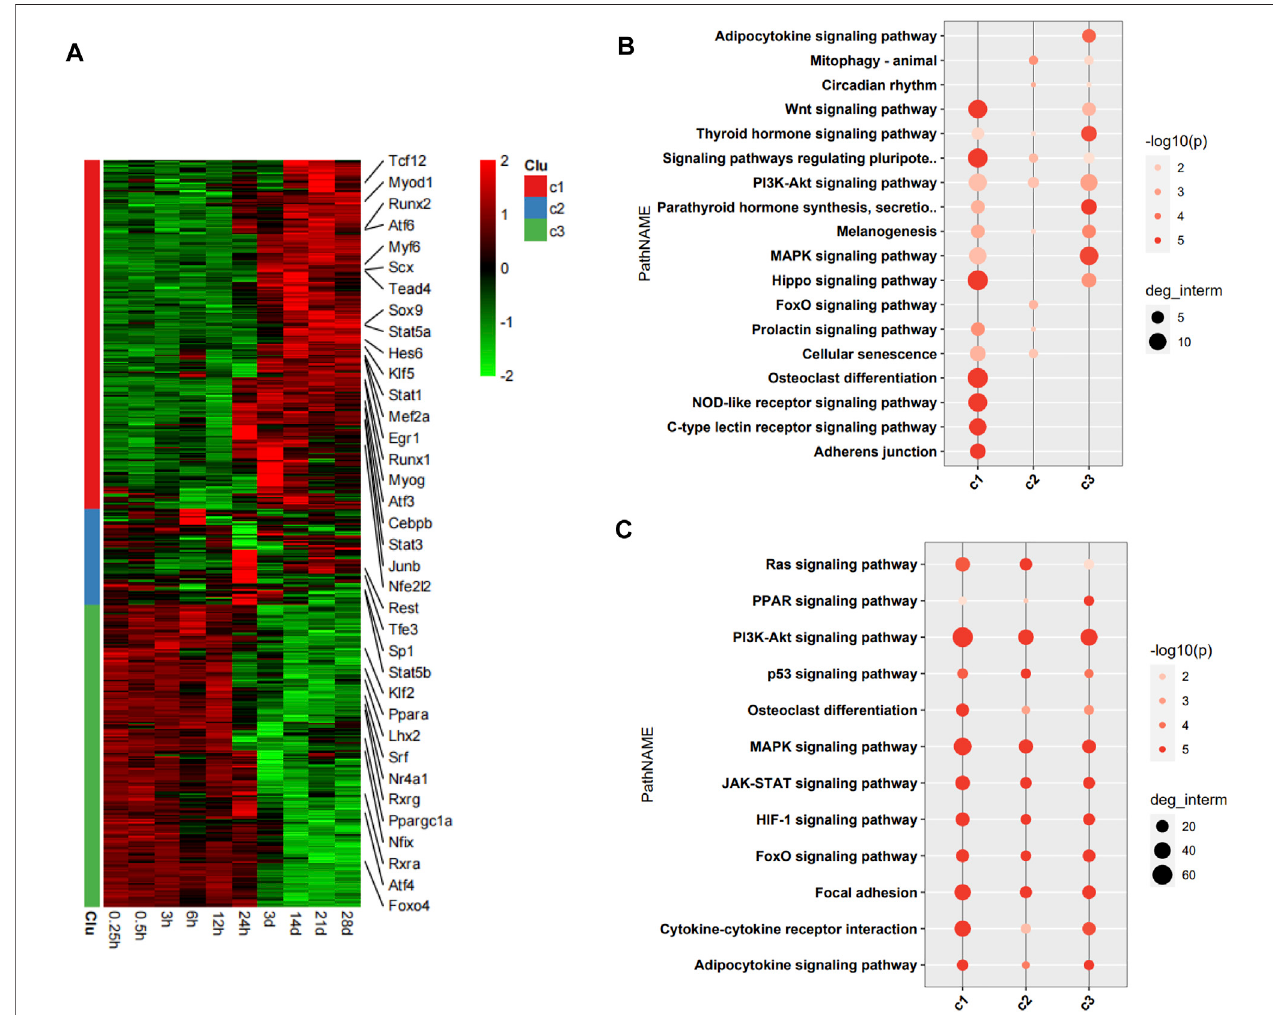
FIGURE3| Functionalanalysisofdifferentiallyexpressedtranscriptionfactors(TFs)andtheirtargetgenes. (A) HeatmapofDEGsencodingTFs,with36TFsrelated to pathophysiology of skeletal muscle indicated on the right. (B) Enrichment analysis of target genes of differentially expressed TFs. (C) Enrichment analysis of target genes of differentially expressed TFs associated with the pathophysiology of skeletal